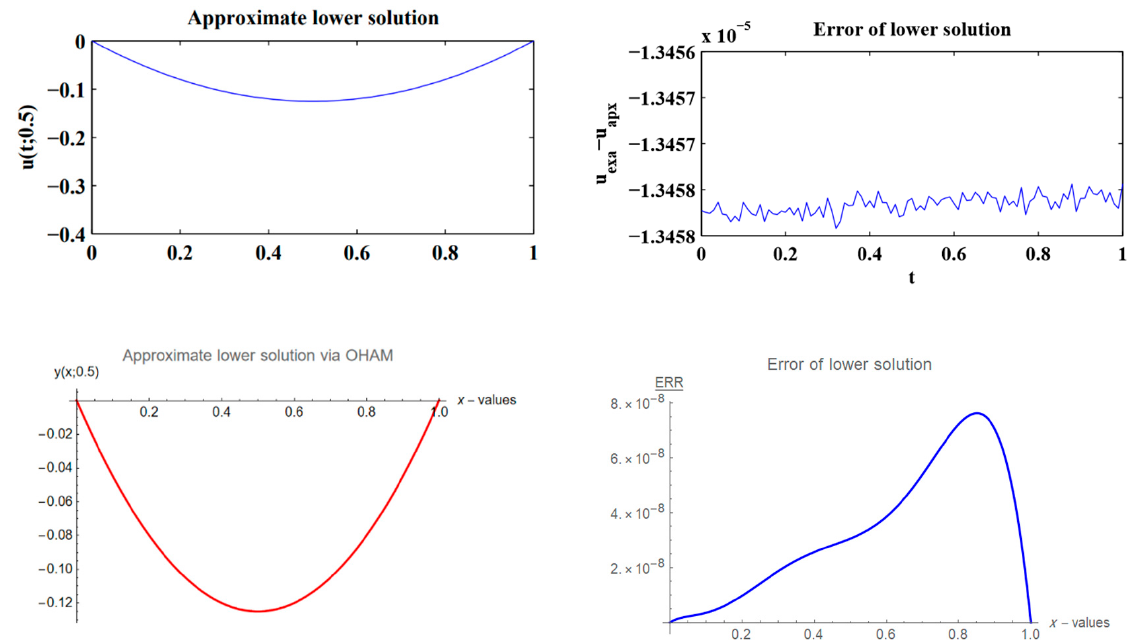
Figure 3. Comparison of the lower approximate solution for Equation (31) using the fi fth-order FF- OHAM and the fi fth-order SCM for 𝛼 = 0.5 and ∀𝑥 ∈ [0,1] .